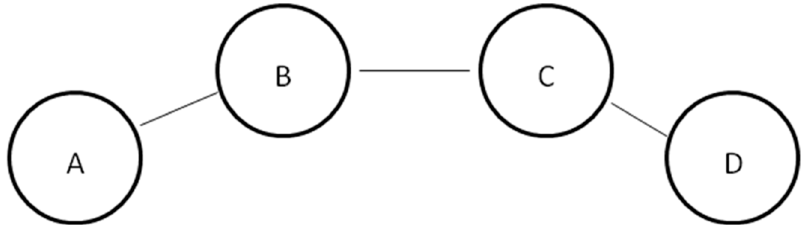
Figure 2. Study 2—Depiction of the lines of communication between members of the four-person work team.